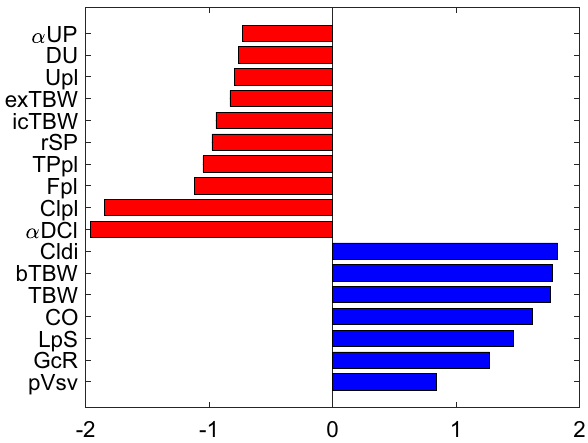
Figure 7. Relative sensitivity of the simulated Kr value at the 5th minute of HD (priming saline discarded) to the values of selected model parameters (only the parameters with the relative sensitivity above ± 0.5 are shown). Symbol meanings: αUP—fraction of LpS attributed to large pores, DU—urea clearance (used also for all other solutes in the model, except for creatinine and bicarbonate), Upl—pre-dialysis plasma urea level, exTBW and icTBW—fractions of normal total body water attributed to extravascular extracellular space and extravascular intracellular space, respectively, rSP—small pore radius, TP—pre-dialysis total protein level, Fpl—normal plasma water fraction, Clpl—pre-dialysis plasma chloride level, αDCl—Gibbs-Donnan coefficient for chloride across the dialyzer membrane, Cldi—chloride concentration in the dialysis fluid, bTWB—fraction of normal total body water attributed to blood, TBW—total body water, CO—normal cardiac output, LpS—whole-body capillary hydraulic conductivity, GcR—low-pressure (cardiopulmonary) gain of the baroreflex mechanism controlling vascular resistance, pVsv—normal fraction of total blood volume attributed to small veins and venules. For figure clarity, the following parameters (sensitivities) were not shown: Napl—pre-dialysis plasma sodium level (−8.7), Nadi—sodium concentration in the dialysis fluid (9.0), Fpl0—pre-dialysis plasma water fraction (12.4), αDNa—the Gibbs-Donnan coefficient for sodium across the dialyzer membrane